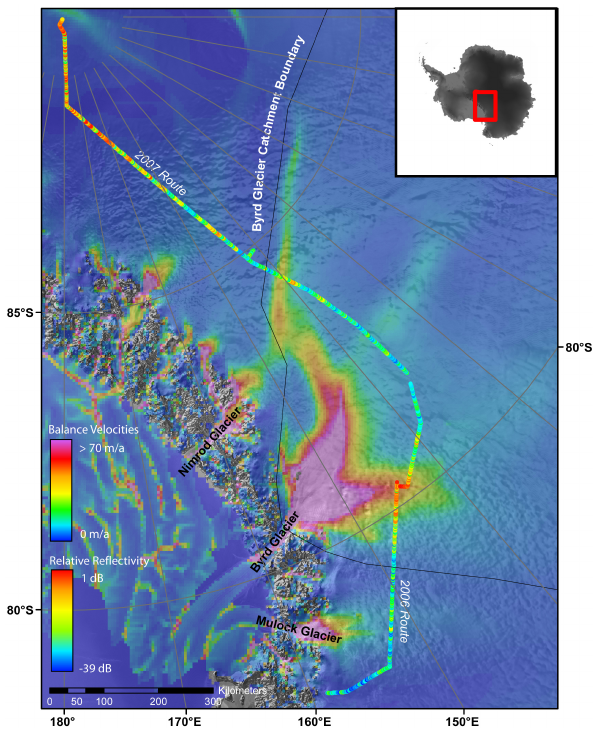
Fig. 1. Map showing the 2006–2008 US-ITASE route, Taylor Dome to South Pole. Color along the route indicates relative basal reflec- tivity in dB. Also depicted in color are the balance velocities. The correspondence between areas of high basal reflectivity (wet bed) and ice speed is most notable in portions of the Byrd Glacier catch- ment.